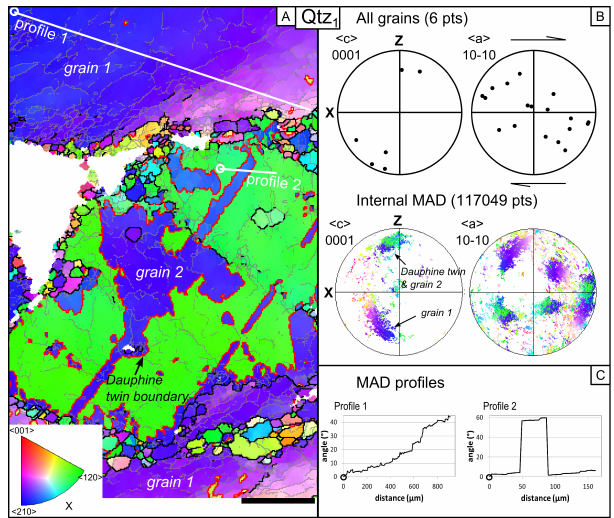
Figure 7. (a) GB (grain boundary) + IPF (inverse pole figure) map of a Qtz 1 grain from orthogneiss (acquisition location marked in Fig. 5a), scale bar 200µm. Subgrain boundaries are marked as grey lines, grain boundaries are black and Dauphine twin boundaries are red. White pixels are non-indexed points or other phases. (b) Pole figure plots showing the crystallographic orientations of all anal- ysed Qtz 1 grains (top) and internal misorientation angle distribu- tions of each pixel in the map (a) (bottom). (c) Misorientation pro- files across two selected regions in the map (a) , where the profiles are marked with white lines and the white circle represents starting